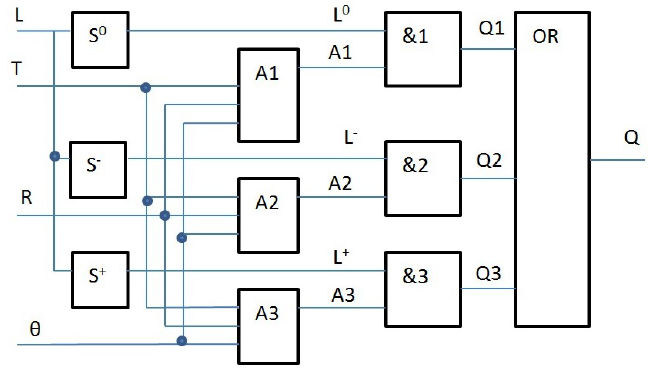
Fig. 10. Logical scheme for assessing the quality of knowledge